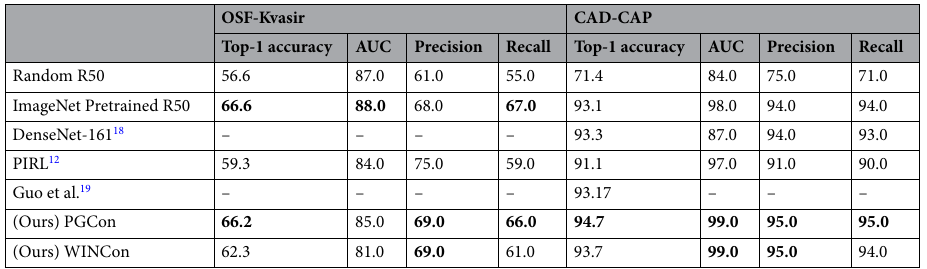
Table 4. Pathology classification with full fine tuning on OSF-Kvasir and CAD-CAP dataset. All methods except DenseNet-161 are on ResNet-50 (R50) and full fine tuning includes BatchNorm training. The baseline ImageNet Pretrained R50 refers to supervised ImageNet pretraining with full fine-tuning. CAD-CAP: both PGCon and WINCon match or outperform ImageNet pretraining as well as fully supervised learning (with Imagenet pretraining) on DenseNet-161 18 , OSF-Kvasir: both methods close the gap with baselines. Significant values are in